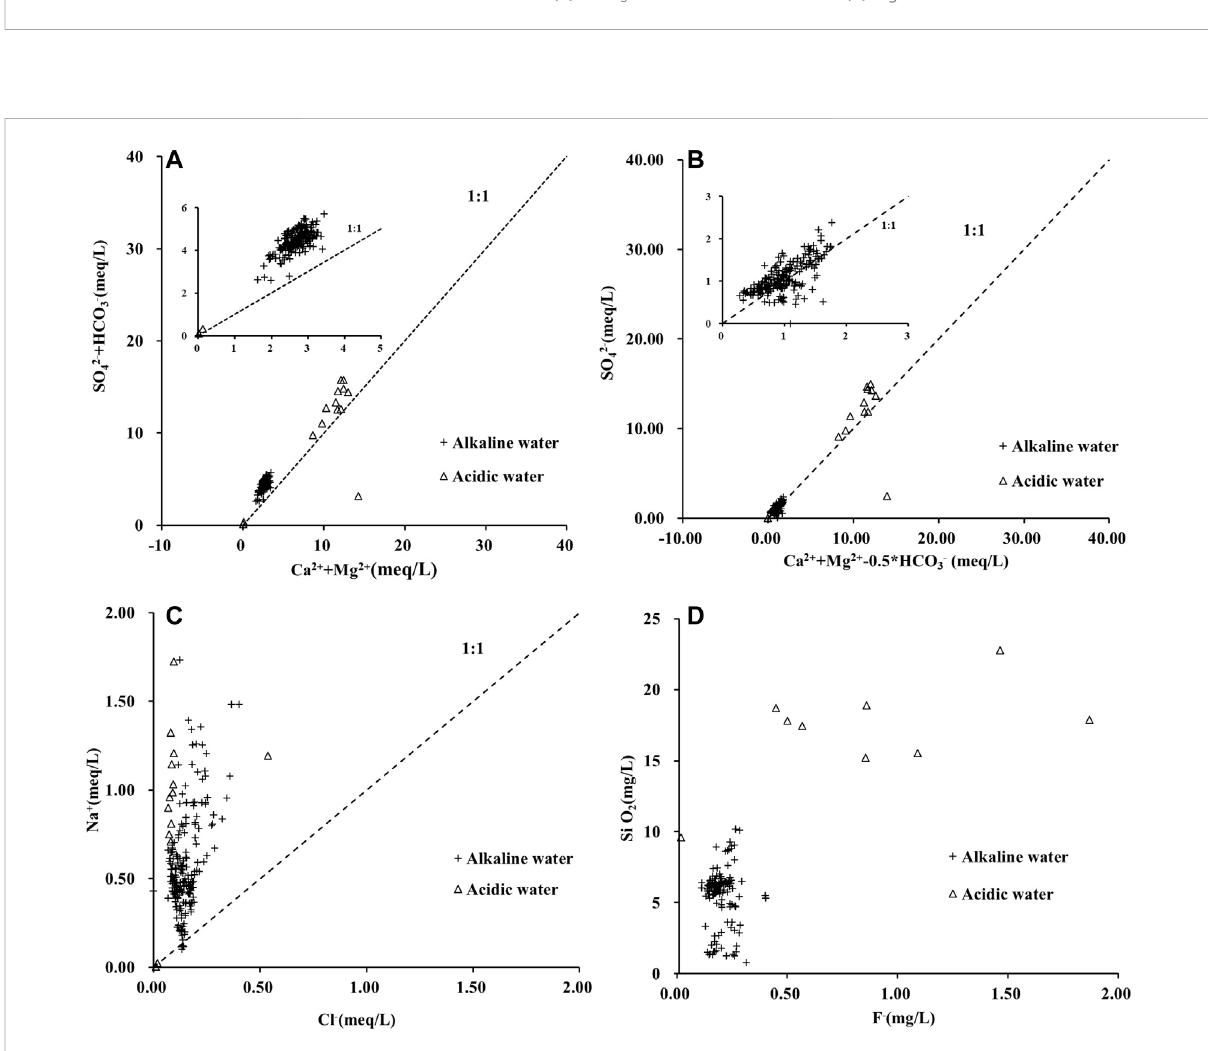
FIGURE 5 Recognition ofthecontribution ofminerals ’ dissolutiontowaterchemicalcompositionbasedonscatterplotsof (A) Ca 2+ +Mg 2+ versusHCO 3 − + SO 4 2 − ; (B) (Ca 2+ +Mg 2+ ) − 0.5*HCO 3 − versus SO 4 2 − ; (C) Na + versus Cl − ; (D) F − versus SiO 2 .